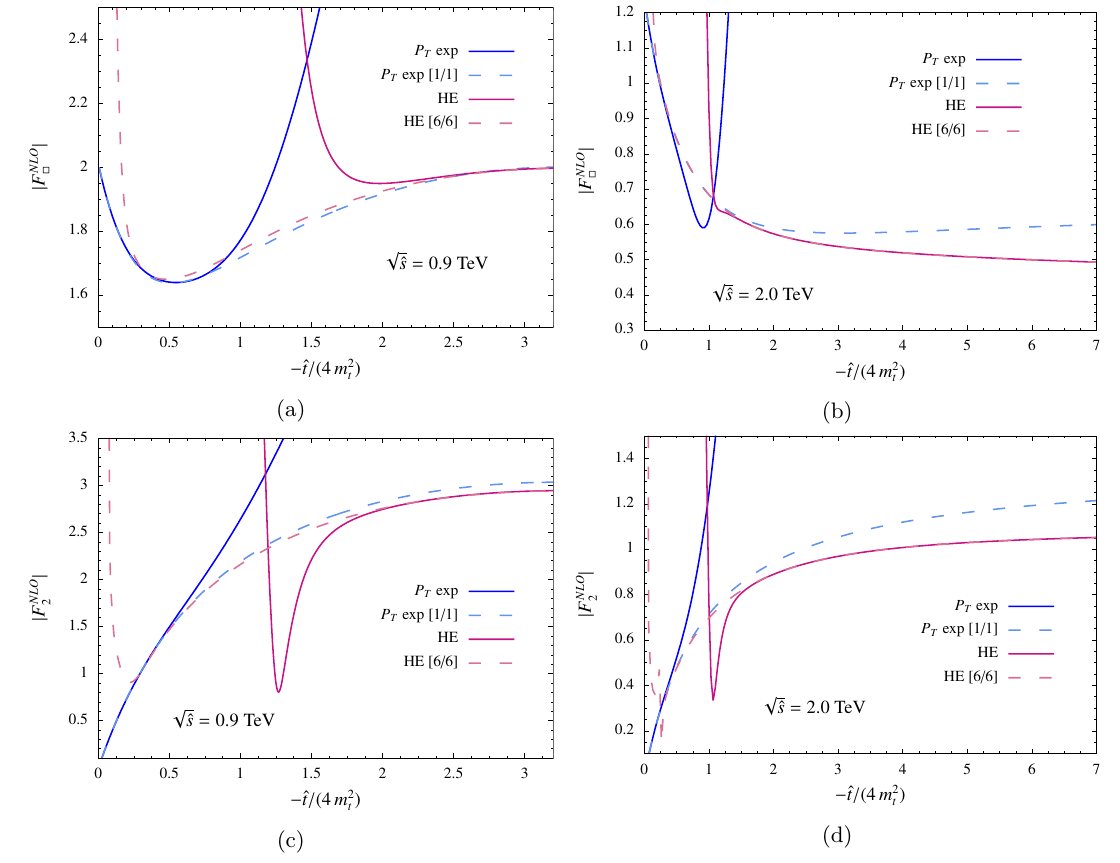
Figure 3. Modulus of the box form factors contributing to gg → HH at NLO, for a fixed value of √ √ (a,c) ˆ s = 0 . 9 TeV and (b,d) ˆ s = 2 TeV. The p and HE expansions are shown as solid blue and T purple lines, respectively, while the [1,1] p - and [6,6] HE-Padé are shown as dashed light blue and T pink lines,